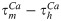
Assessing the dependence of fres and QZ on the τmCa−τhCa linear correlation.a. Parameter values for each model were changed along a line parallel (‖, blue) to the correlation line (black) or along a perpendicular line (┴, grey). This was done for models with high (cyan; a1), low (red; a2) and intermediate (grey; a3) g¯Ca models. For each model and each line, ‖ or ┴, we fit a line to the relative change in either fres or QZ as a function of the relative change in g¯Ca. b. The sensitivity values of fres or QZ to ‖ or ┴ are shown for the three groups.